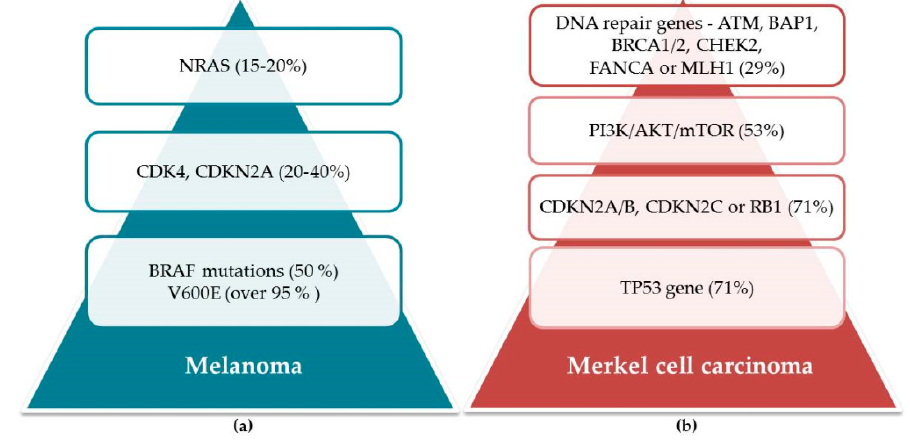
Figure 5. Mutations resulting in melanoma ( a ) and Merkel cell carcinoma ( b ).